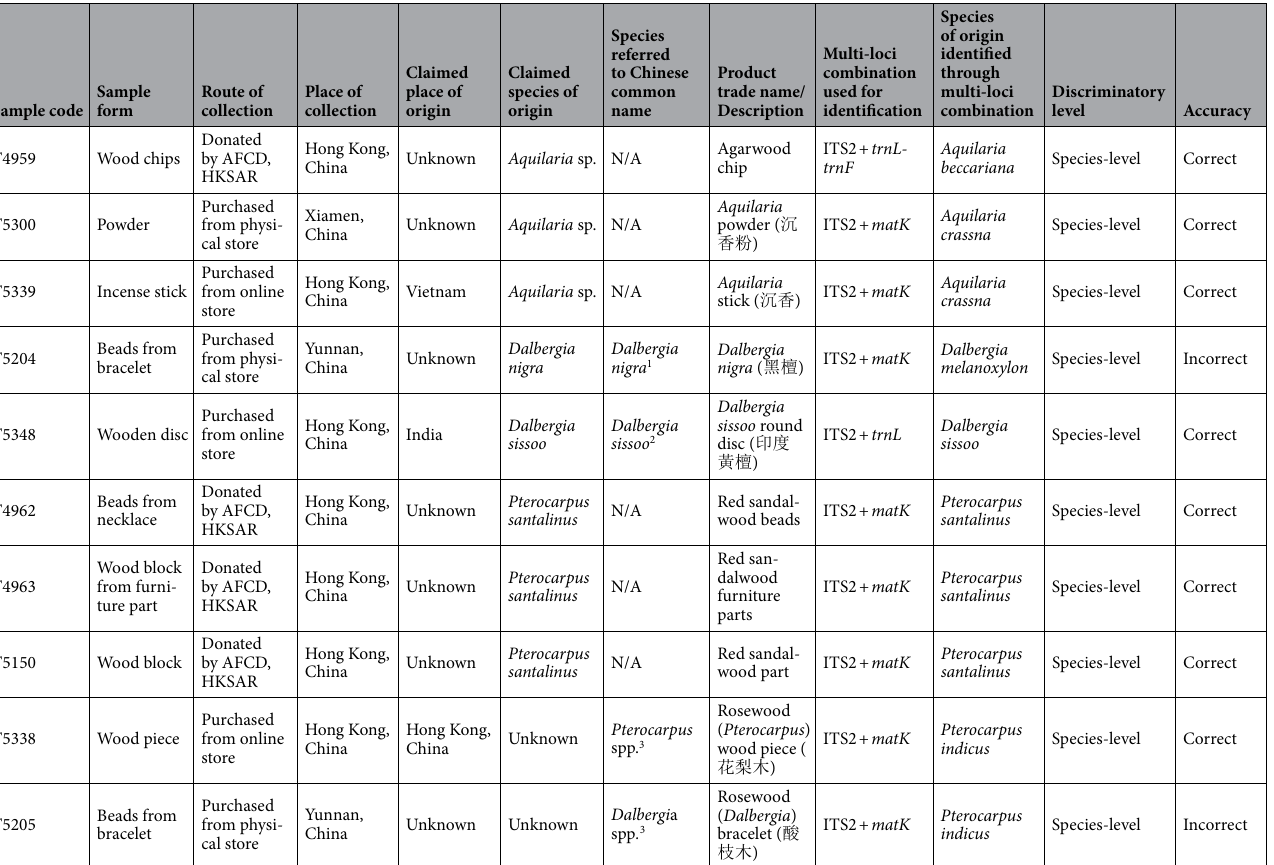
Table 2. List of commercial wood products collected. 1 Protection of Endangered Species of Animals and Plants Ordinance, Cap 586 (2018). 2 Chiayi Botanical Garden. Chungpu Research Center, Forestry Research lnstitute, Council of Agriculture of Taiwan. Retrieved from https:// cptfri. tfri. gov. tw/ on 01 March, 2021. 3 The National Standards of the Republic of China (GBT18107-2017, “Hongmu”). General Administration of Quality Supervision, Inspection & Quarantine of the People’s Republic of China (AQSIQ), Standardization Administration of the People’s Republic of China (SAC). Retrieved from http:// www. gb688. cn/ bzgk/ gb/ newGb Info? hcno= 6E961 C6DB7 8254E F883B 5053D 08BFA 3B on 01 March,